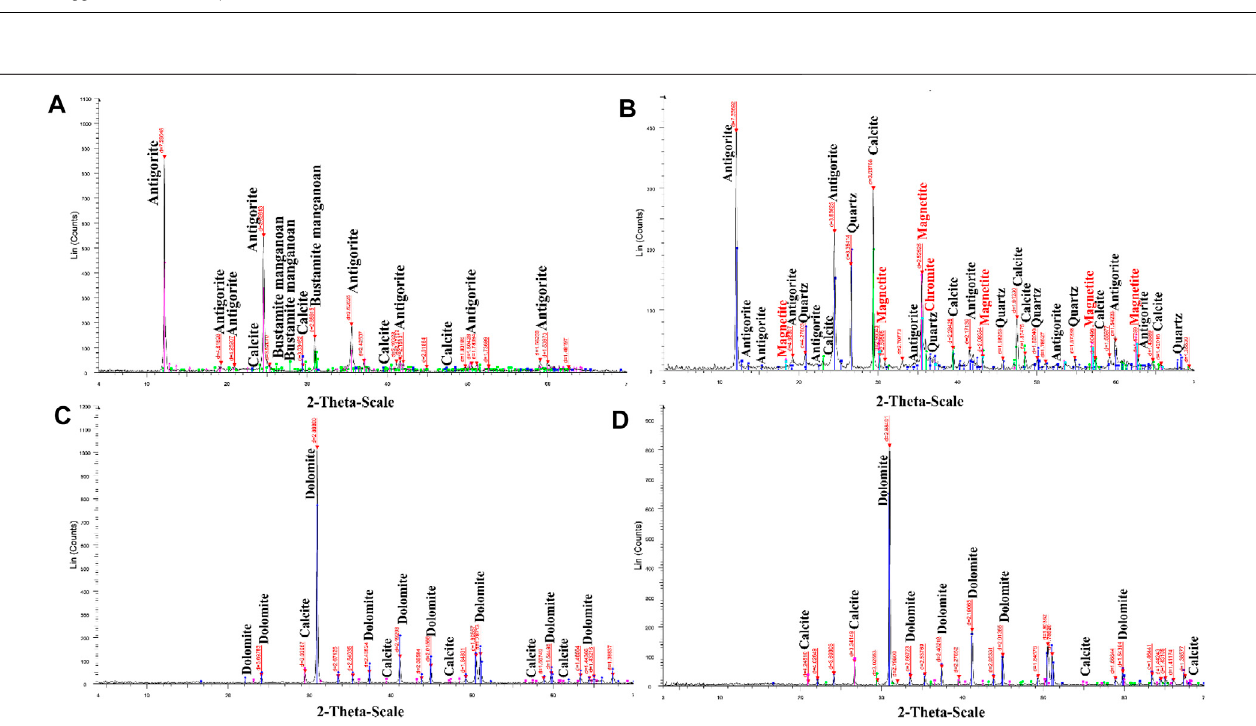
FIGURE15| X-raydiffractionpatternsoftheserpentinitesshowing (A,B) hydrothermalalterations:carbonizationandserpentinizationwithchromiteandmagnetite ores. (C,D) X-ray diffraction patterns showing carbonization and silici fi cation for the listwaenite studied samples.